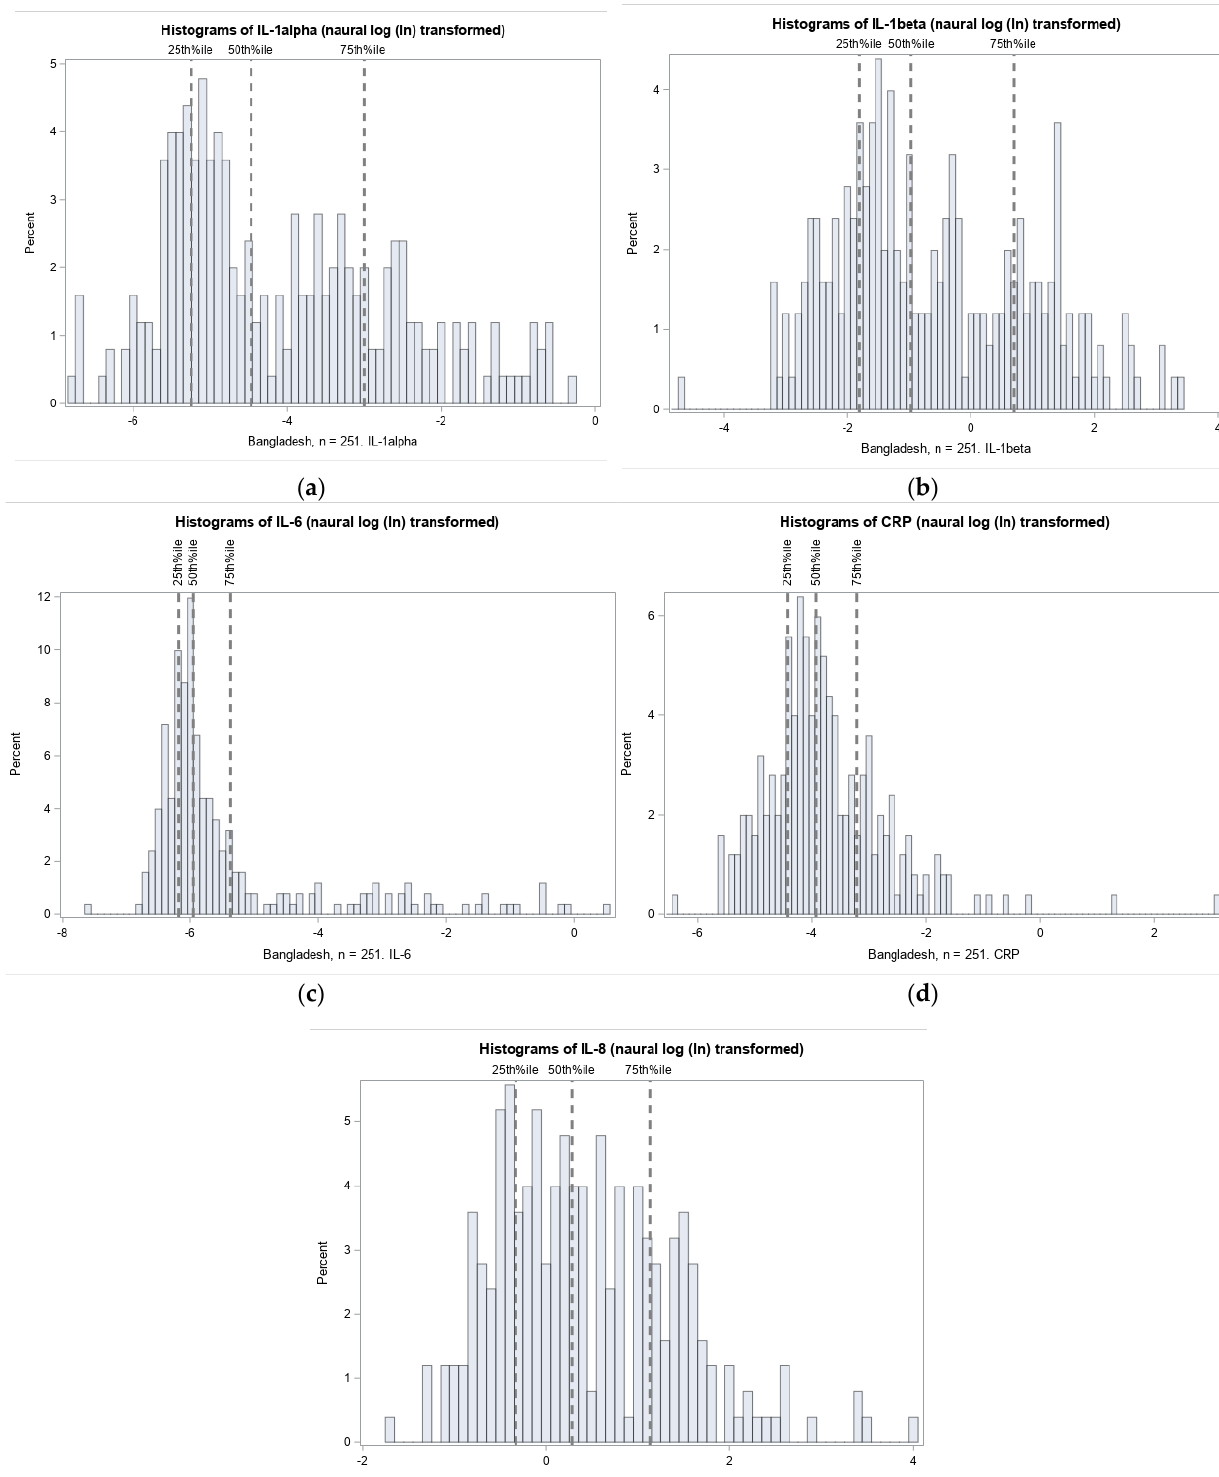
Figure 3. Distribution of inflammation biomarkers (natural log transformed) in Projahnmo cohort. The 75% thresholds for each cytokine are: ( a ) IL-1 α : 0.05 pg/mg total protein; ( b ) IL-1 β : 2.01 pg/mg total protein; ( c ) IL-6: 0.0046 pg/mg total protein; ( d ) IL-8: 3.09 pg/mg total protein; and ( e ) CRP: 0.04 ng/mg total protein.